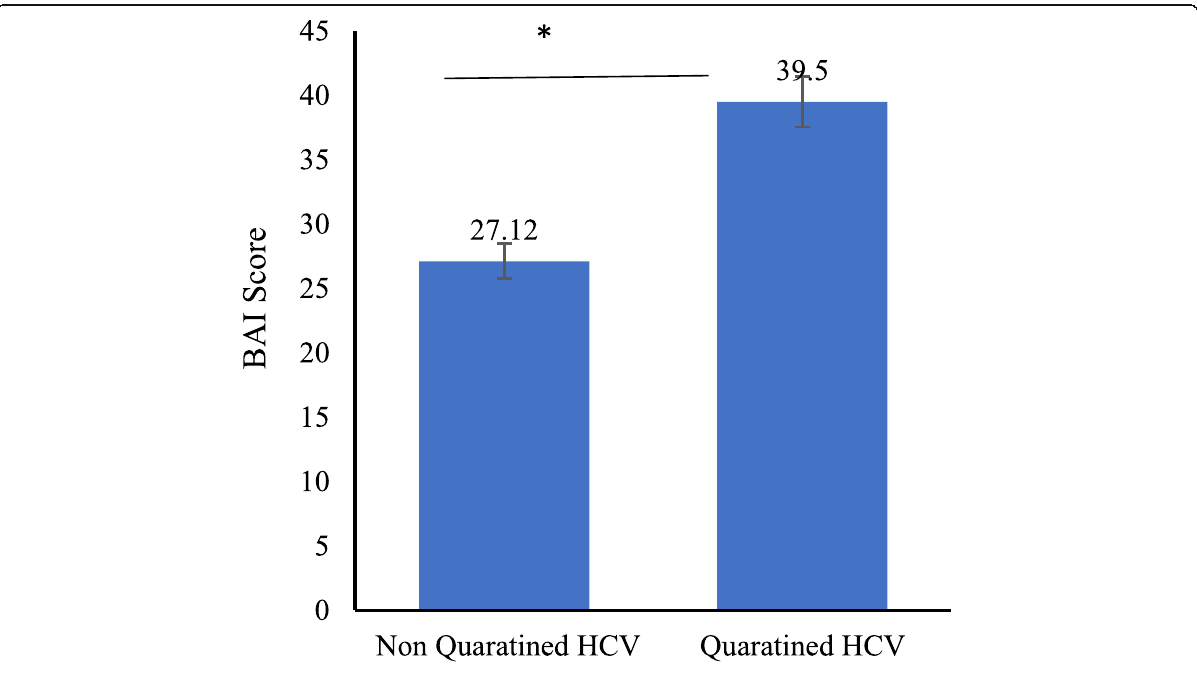
Fig. 1 BAI score of quarantined HCV patients vs non-quarantined HCV patients